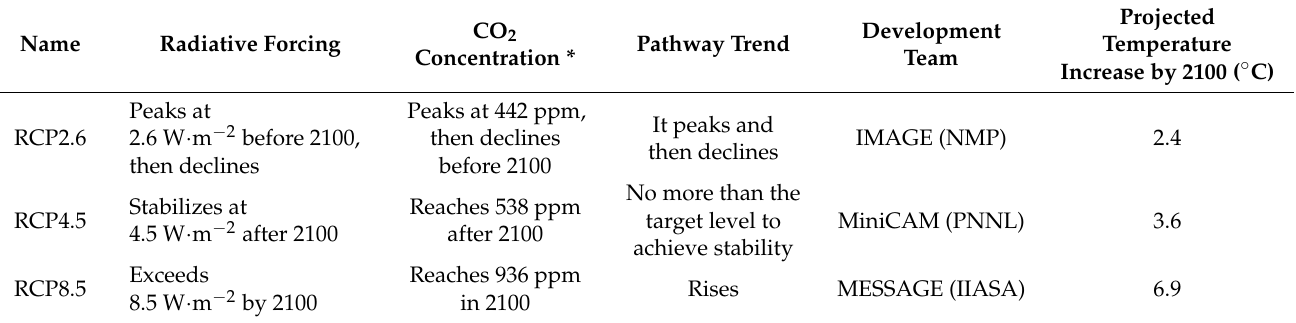
Table 1. Representative concentration pathways used in the present